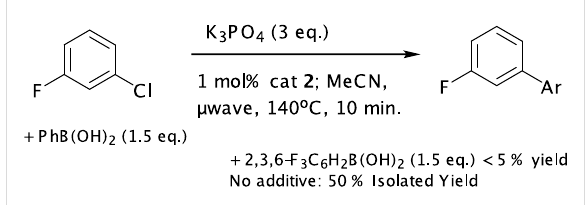
experiment shows that fluorobenzene is not present to any